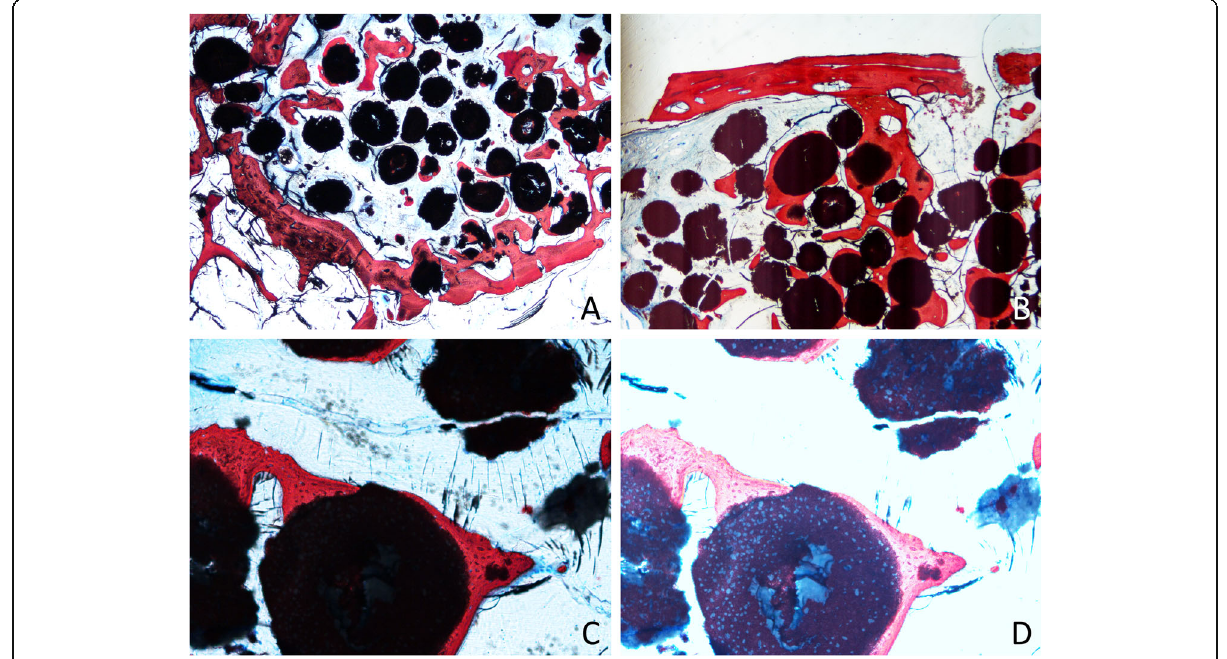
Fig. 4 Photomicrographs of ground sections after 4 months of healing. a Bone formed from the base of the sinus. b Bone plate connected by bridges of the new bone to the close-to-window region. c Particle of the graft surrounded by new bone. d Overexposed image to show the new bone ingrowth within the granules of